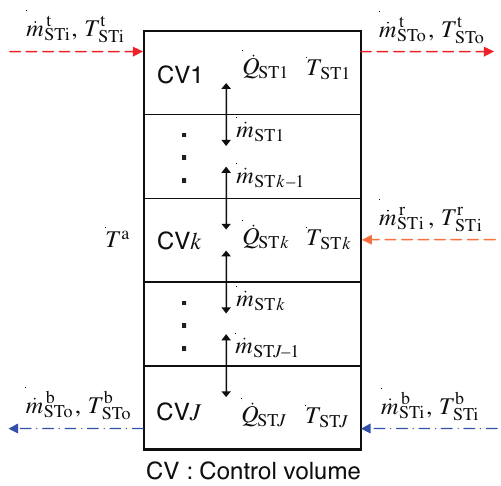
Figure A3. Model for storage